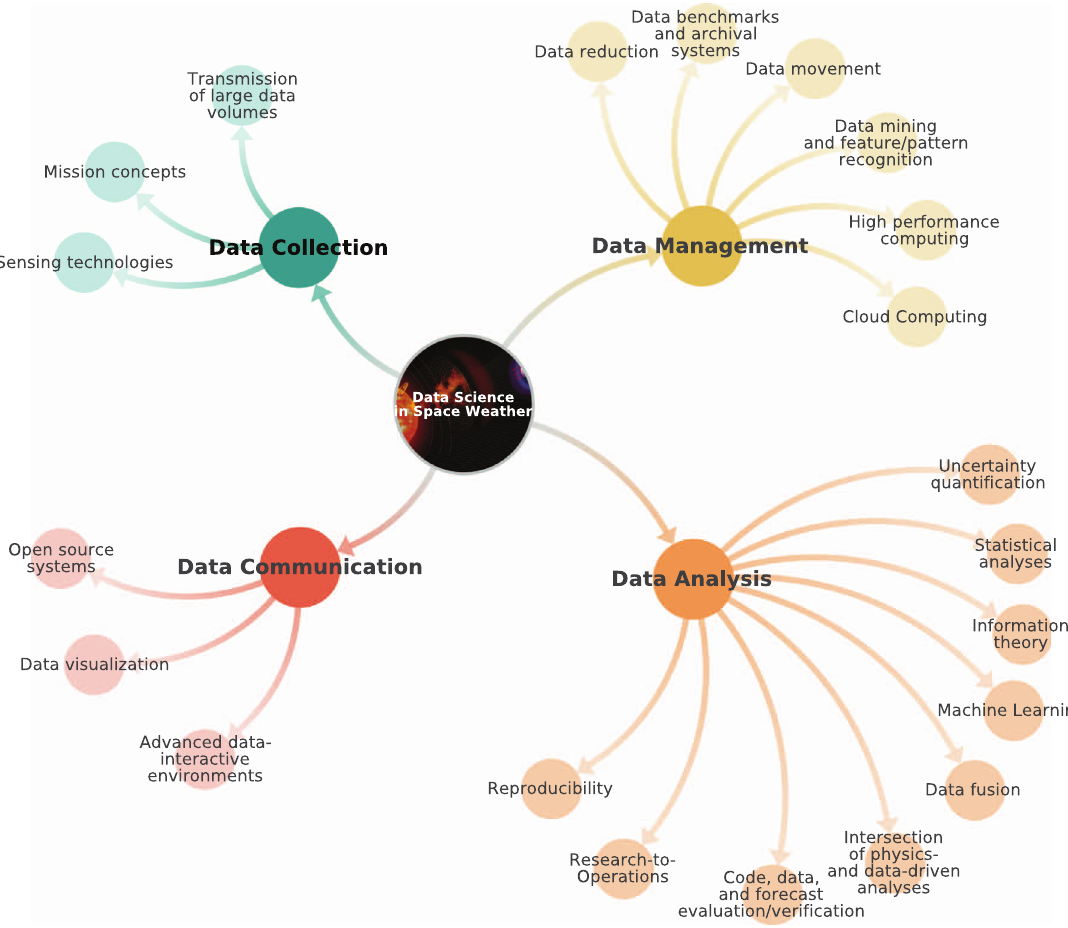
Fig. 1. The “ network ” of data science topics solicited by the Topical Issue and a useful taxonomy for future research. Image created using